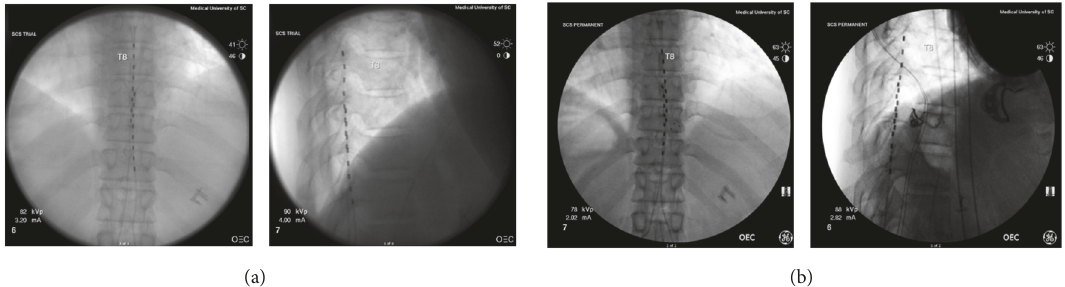
Figure 1: AP and lateral fluoroscopic images demonstrating location of epidural placement of trial leads (a) and permanent leads